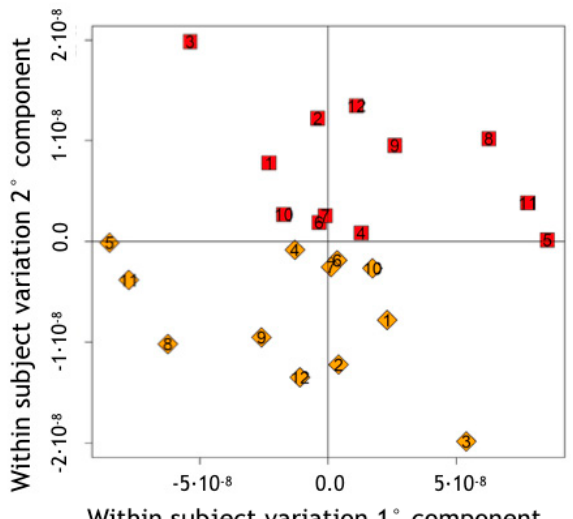
Figure 1. Score plot of Multilevel partial least square (PLS) pairwise discrimination of baseline (B) and after therapy (AT) salivary samples in generalized periodontitis (GP) patients. p -value calculated using a premutation test procedure was < 0.01 ( p = 0.0099).